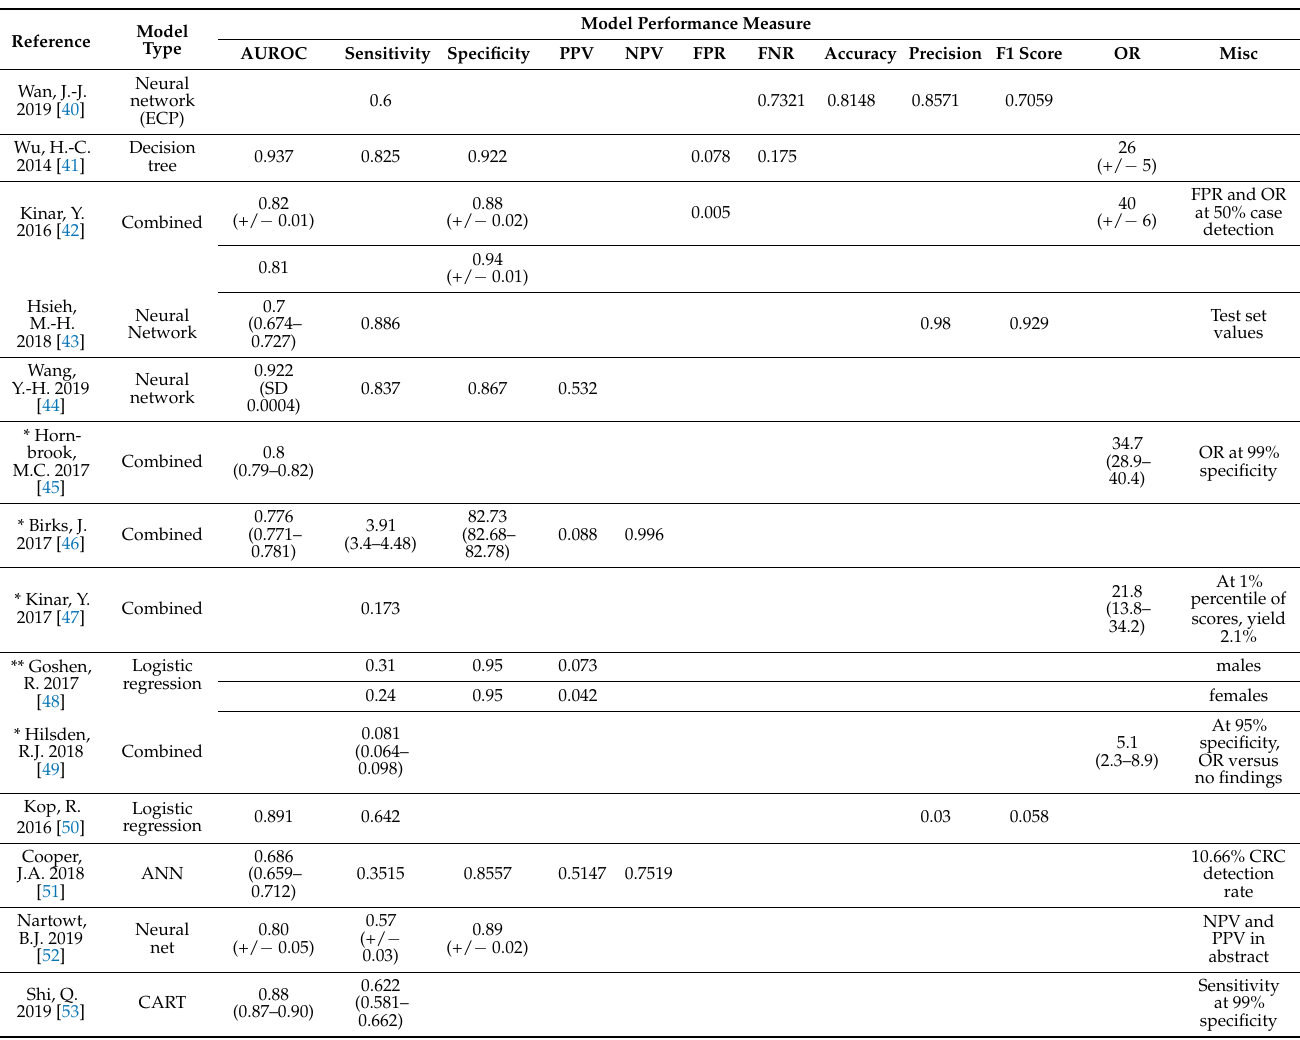
Table 3. Summary of Model Performance Measures—“best” model where multiple models